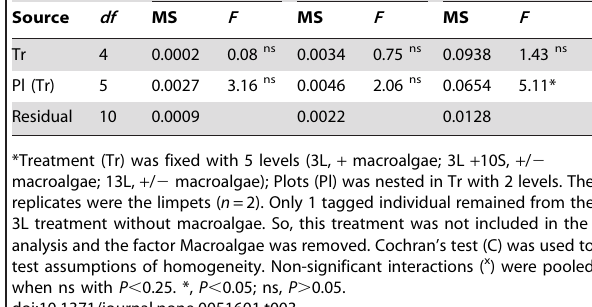
Figure 4. Changes in shell-weight of small limpets. Mean changes in shell-weight ( 6 SE; n =4) of small P. vulgata for each treatment at the end of the experiment. S, small limpets; L, large limpets. Black bars, without macroalgae; white bars, with macroalgae.